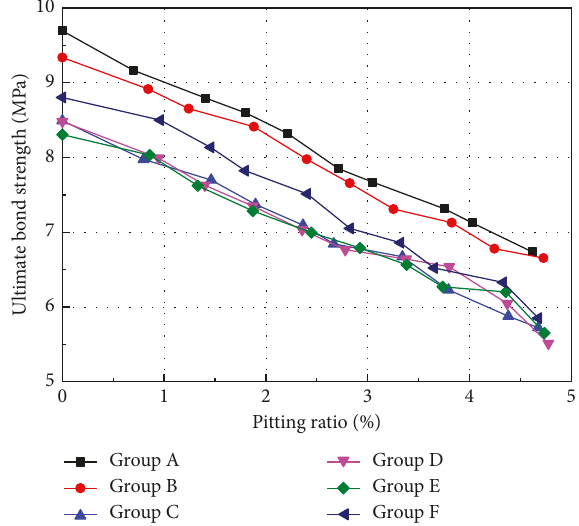
Figure 10: The relationship between pitting ratio and ultimate bond